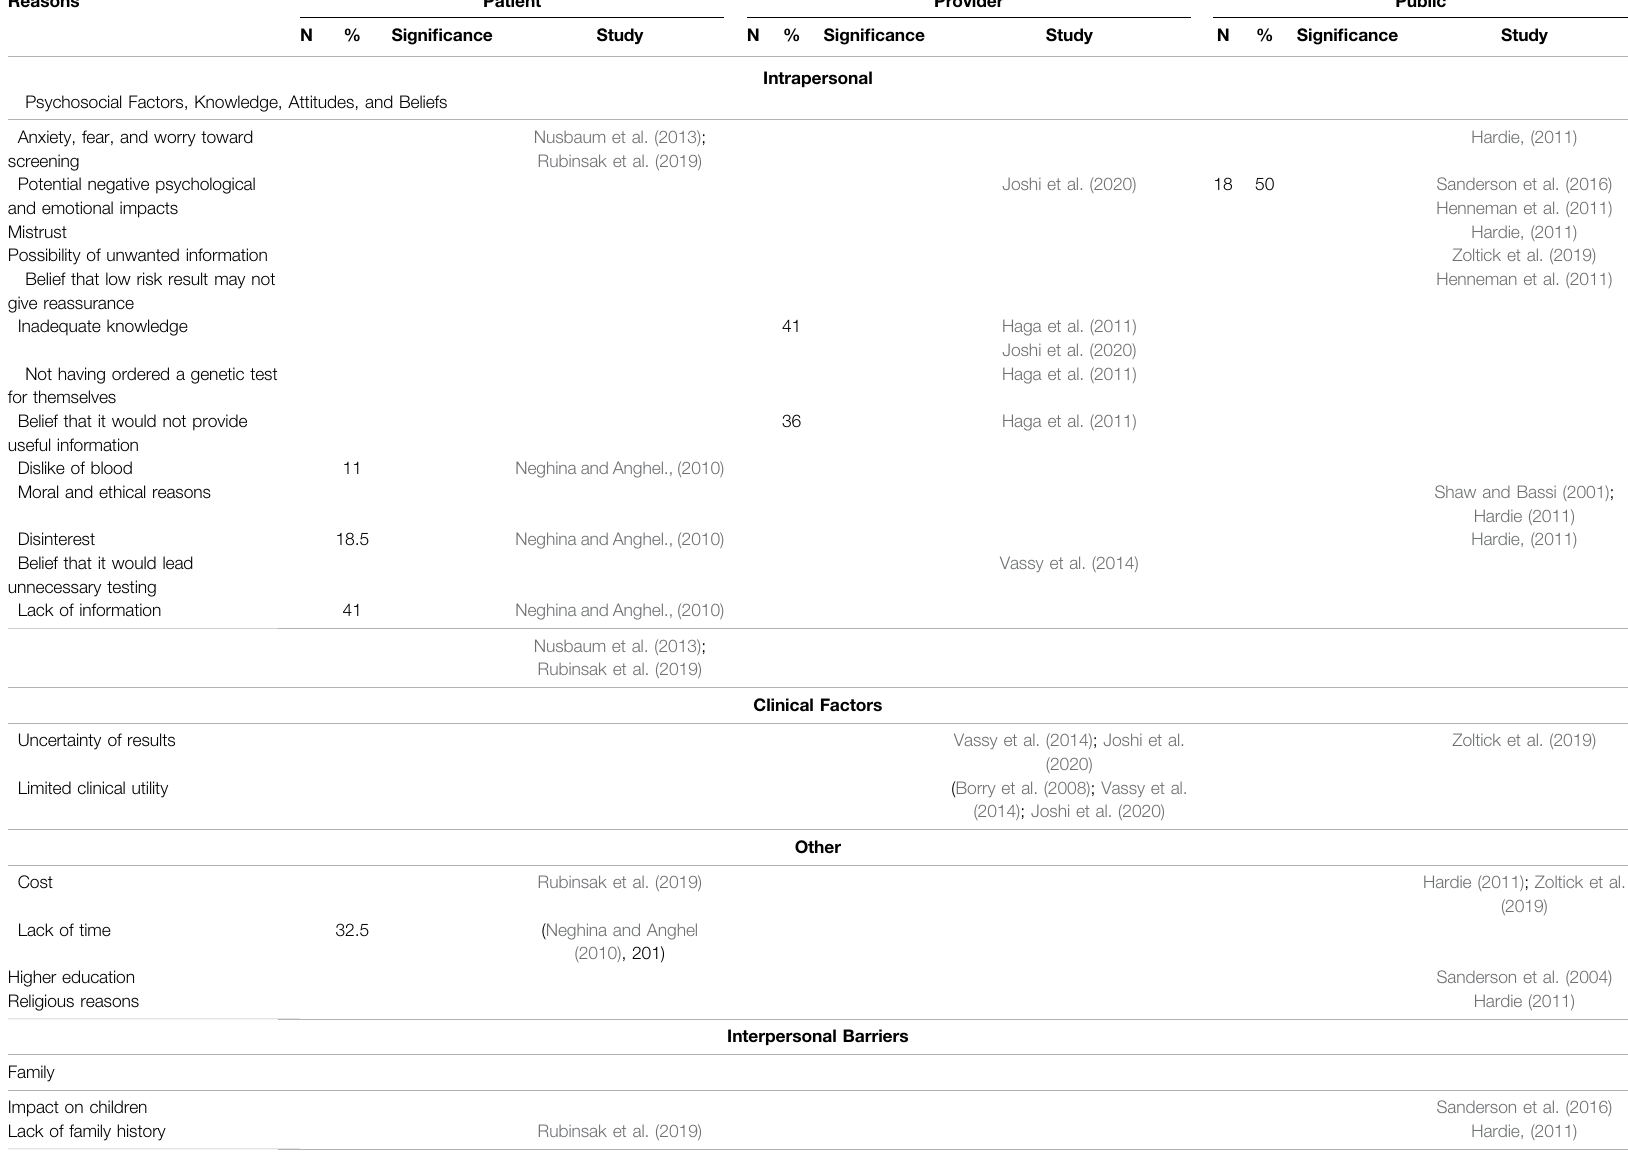
TABLE 2 | Barriers to interest and participation in population genetic